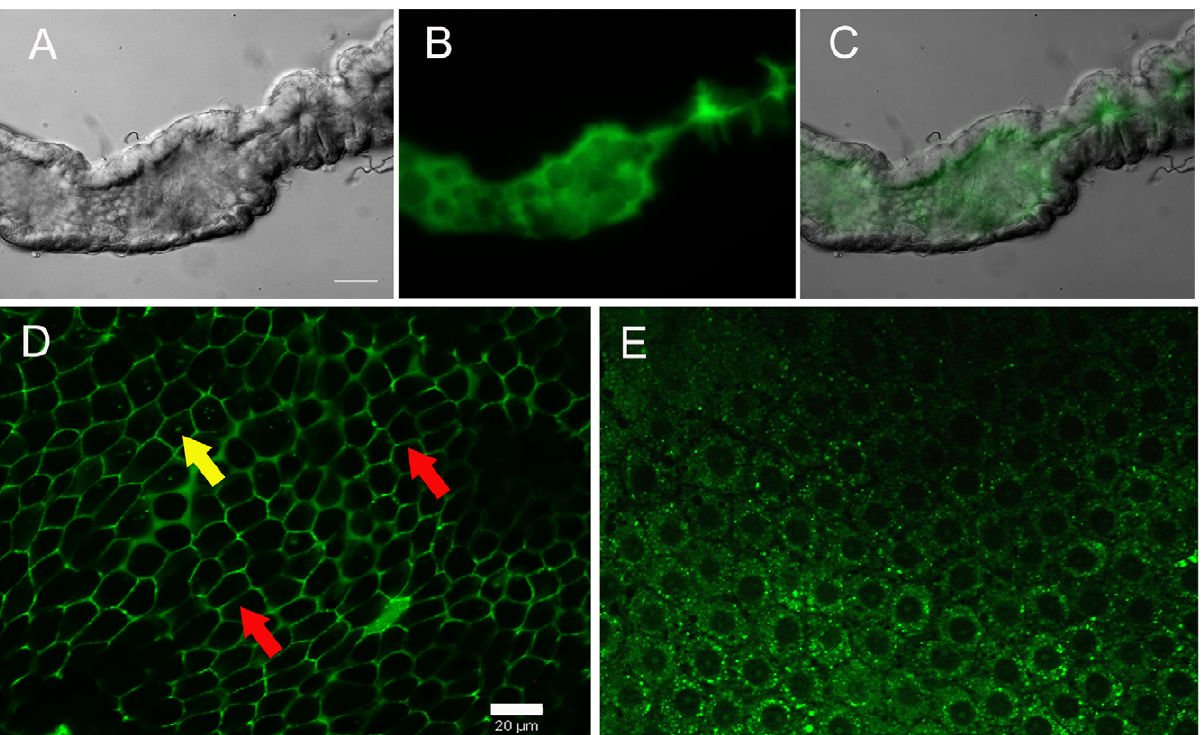
Figure 2. Sites of ROS location in the midgut epithelia. Midguts were incubated with CM-H 2 DCFDA (2 m M) for 20 min, washed and visualized under an epifluorescence (A–C) or confocal microscope (D–E). (A) DIC image of sugar-fed midgut. Scale bar– 100 m m. (B) ROS staining of midgut in (A). (C) Merge of (A) and (B). (D) Confocal image of epithelia from sugar-fed or (E) blood-fed (24 hrs) females showing different patterns of ROS production. Scale bar – 20 m m. The fluorescence intensity is not directly comparable in the images shown in panels D and E because the microscope was set to acquire the best image under each condition to allow optimal visualization of cellular ROS production sites. Red arrows indicate fluorescence associated with the cell periphery. Yellow arrows indicate fluorescence associated with intracellular